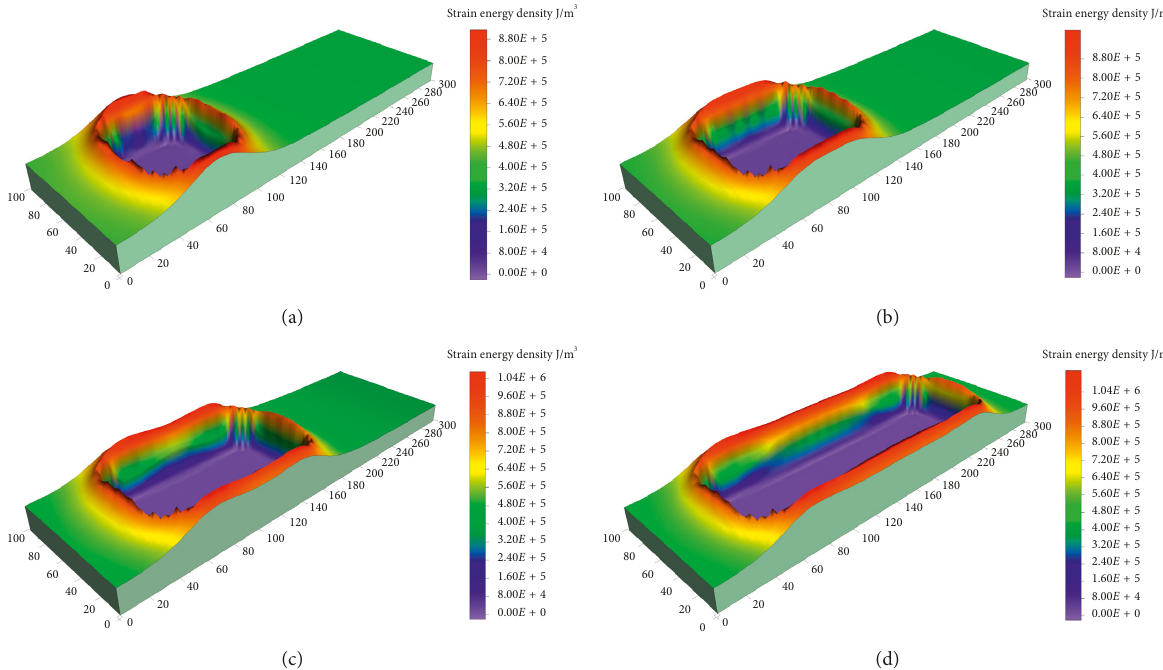
Figure 7: Distribution of strain energy density at different advancing distances when using caving mining method. (a) Working face advanced to 48m. (b) Working face advanced to 72m. (c) Working face advanced to 112m. (d) Working face advanced to 200m.